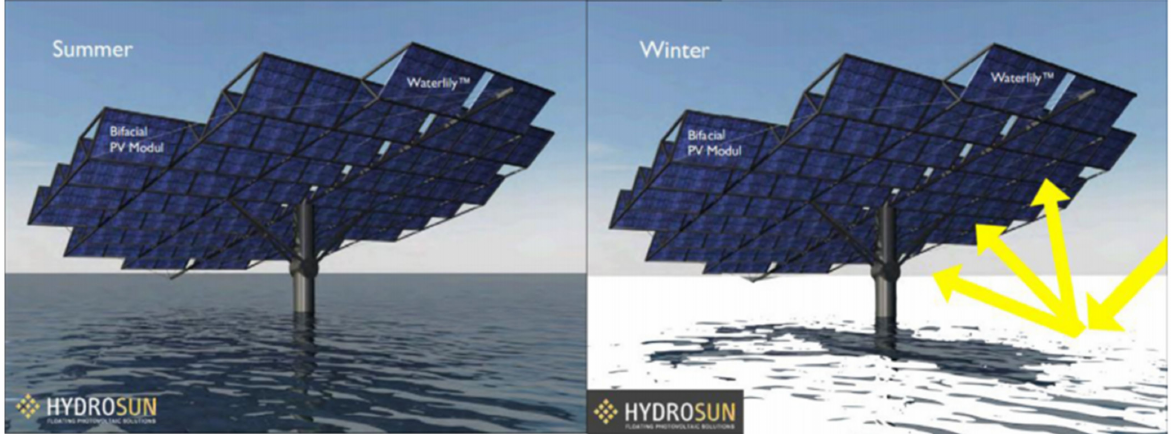
Figure 11. Nature-inspired Solar tree (waterlily design) with bifacial modules. (Source: TNC Consulting AG, Switzer- land)